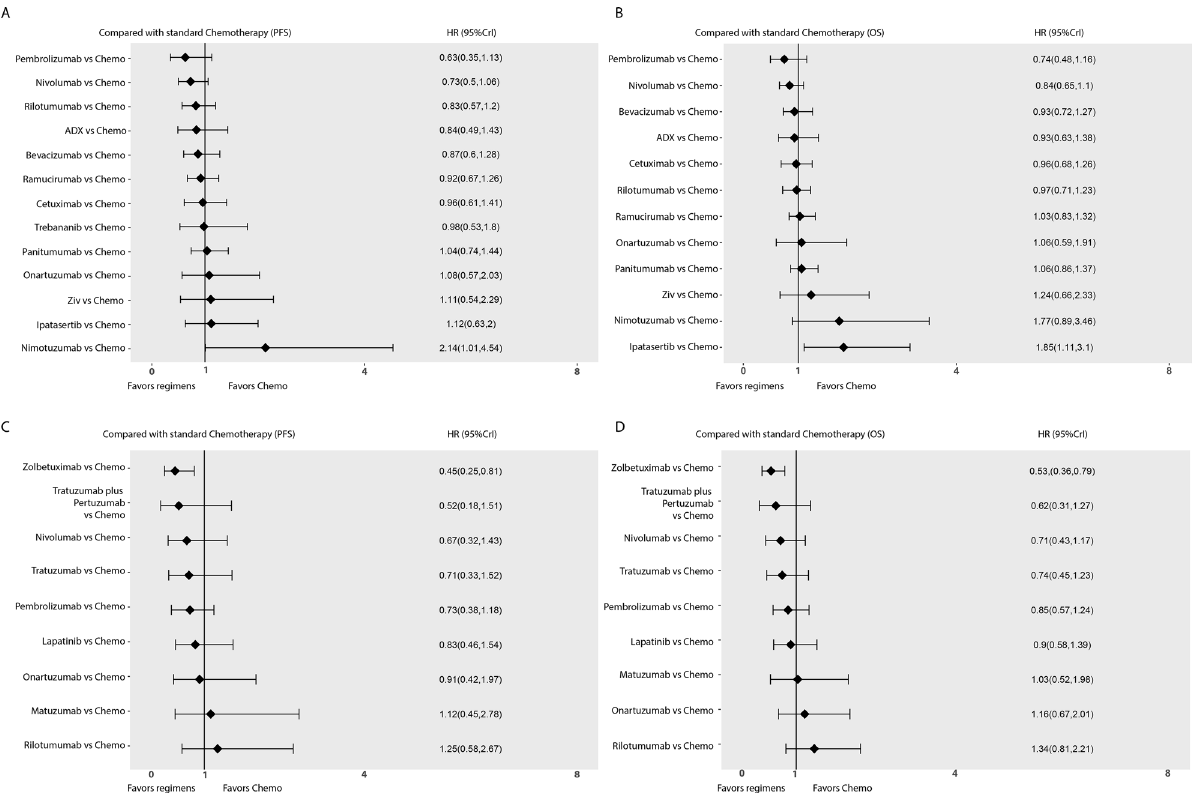
Figure 5. Forest plots of primary outcomes compared with Standard Chemotherapy. ( A ) Forest plots of PFS compared with chemotherapy in average group; ( B ) Forest plots of OS compared with chemotherapy in average group; ( C , Forest plots of PFS compared with chemotherapy in specific positivity group; ( D ) Forest plots of OS compared with chemotherapy in specific positivity